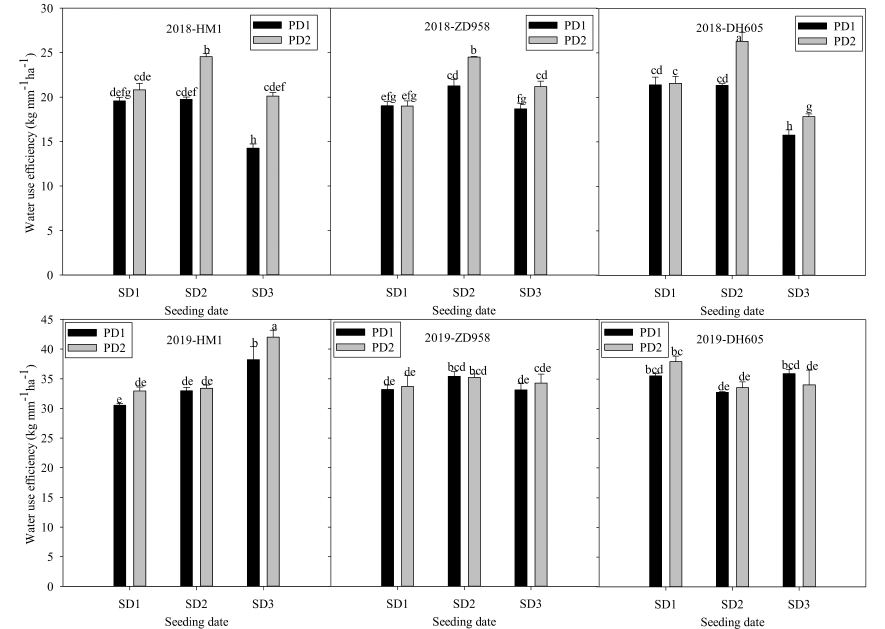
Figure 5. Effects of cultivar, sowing date and plant density on water use efficiency of summer maize. SD1, SD2, and SD3 represent the sowing dates of June 10, June 17, and June 24, respectively. PD1 and PD2 represent the plant densities of 6.75 × 10 4 plants ha − 1 and 8.25 × 10 4 plants ha − 1 , respectively. Different lowercase letters above the columns within one year indicate significant differences at p <